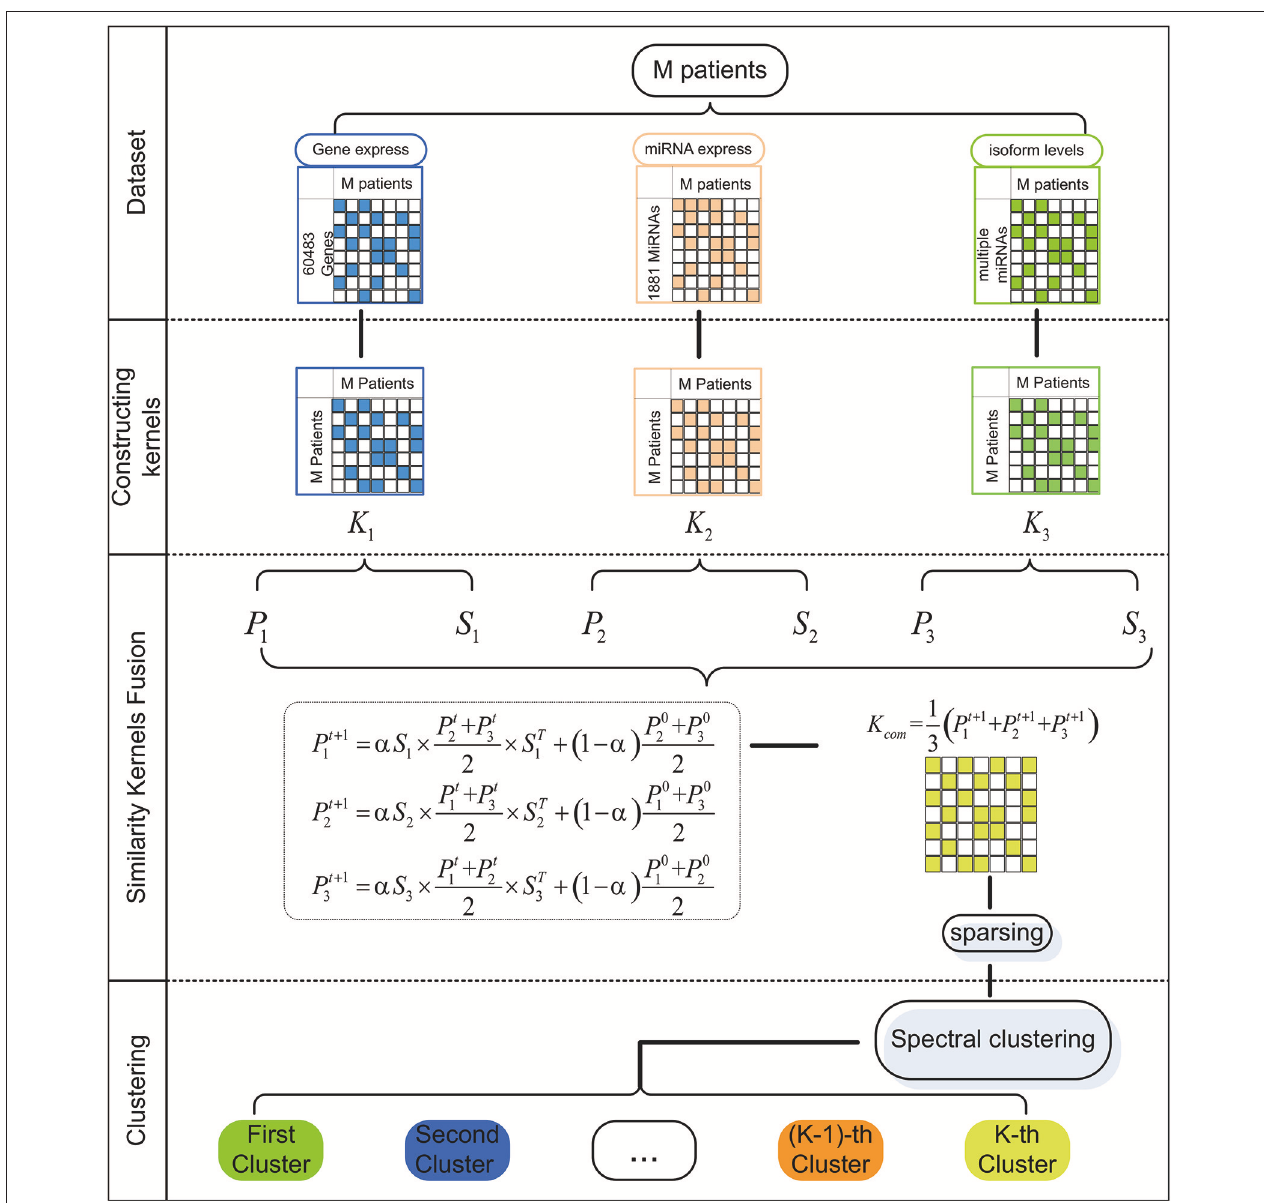
FIGURE 1 | The flowchart of our method for discovering cancer